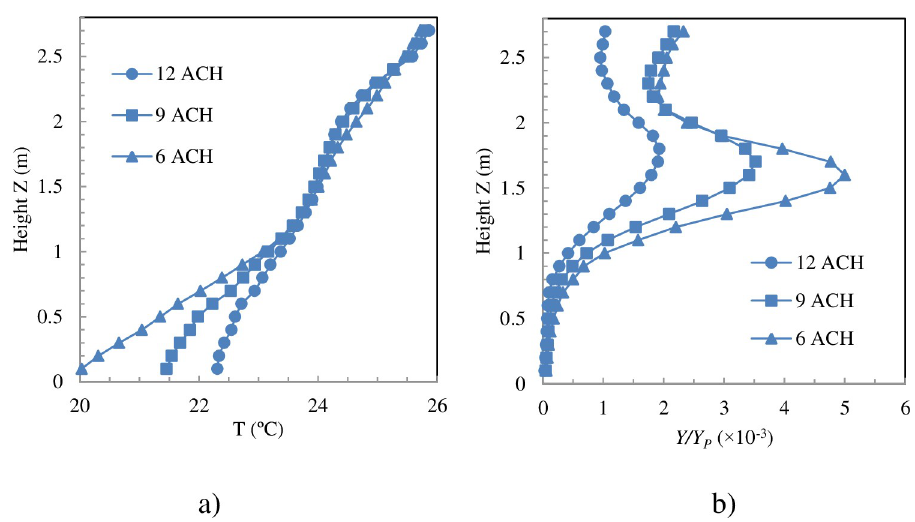
Fig 5. Temperature and percentage of pollutant averaged over time and over vertical planes. Exhaust openings on the bed and radiant wall in front of the HCW (Cases WN).